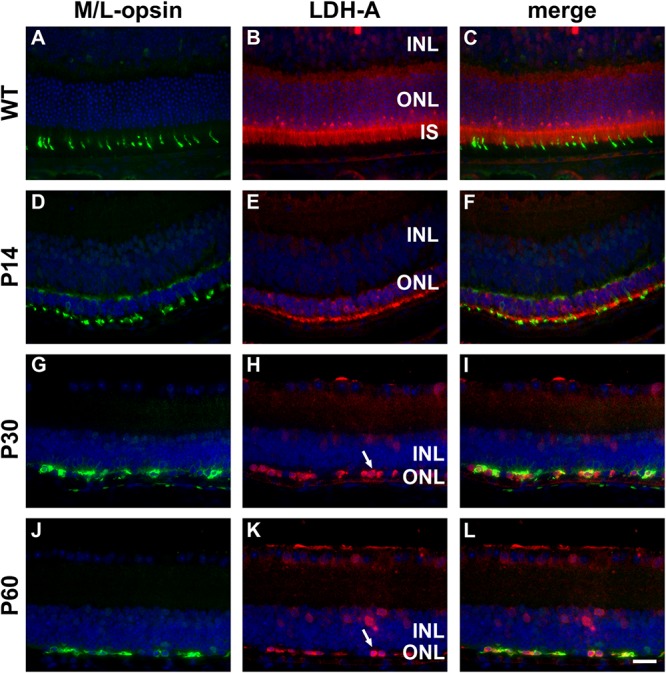
Representative double labeling immunofluorescence images of LDH-A with M/L-opsin in wild-type (WT) mouse retina and in Rd1 mouse retinas from postnatal day (P) 14 to P60. (A–C) In WT retinas, LDH-A is associated with rod and cone photoreceptor somas, inner segments and axonal terminals, together with cells in the inner retina. (D–F) At P14, hexokinase II colocalizes with M/L-opsin in shrunken inner segments (arrow) and weakly labels photoreceptor somas and axonal terminals. (G–L) From P30 to P60, the ONL comprises a single layer of surviving cones largely devoid of segments. LDH-A is observed in surviving cone somas (arrows). All images were captured from the superior retina, which comprises primarily M/L-cones. INL, inner nuclear layer; IS, inner segments, ONL, outer nuclear layer; RPE, retinal pigment epithelium. Scale bar: 20 μm.